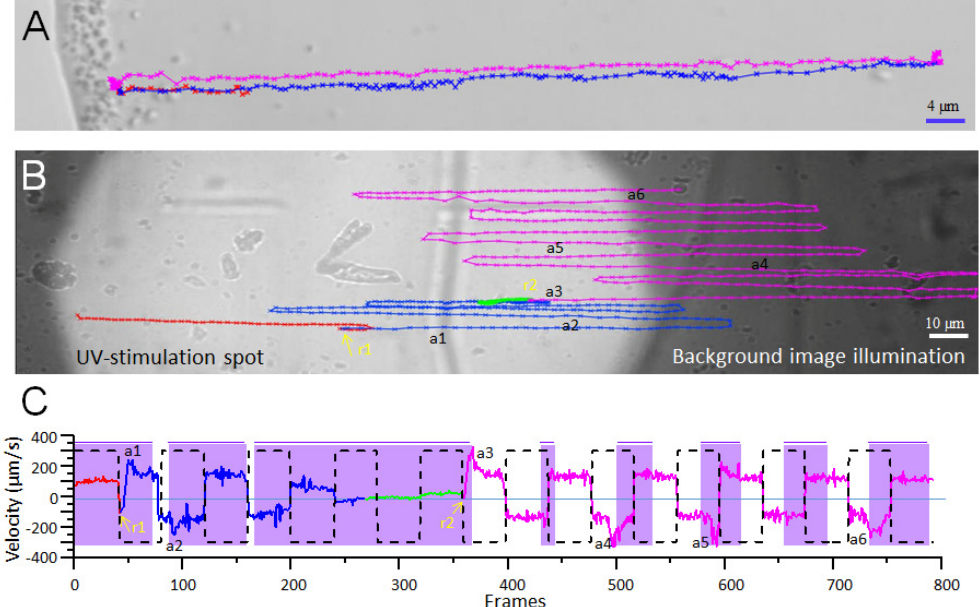
Figure 3. Ping-pong motion and photo-sensitive motility. ( A ) a magnetotactic bacillus of ~ 4 µm swims northward (red track) until the edge of the droplet. Then, it swims southward, opposite to the north-seeking swimming direction to the center of the droplet (blue track), which is followed by a returning north-seeking (magenta track). ( B ) is a representative photosensitive swimming behavior of magnetoglobules and ( C ) is an ImageJ analysis of the data [8]. The dot-line square curve indicates the north direction of the alternating magnetic field. Positive velocity means that the magnetoglobule swims from left to right on the image whilst the negative values are opposite. The velocity curve colors in ( C ) correspond to the same colors of the swim tracks in ( B ). When the velocity curve is on the same side as the field curve using zero velocity line as a reference, the magnetoglobule exhibits a north-seeking magnetotaxis (e.g., red and green tracks), otherwise it displays a south-seeking magnetotaxis (blue and magenta tracks). Violet areas show the swimming of the magnetoglobule in the UV spot. Yellow arrows with r1 and r2 indicate the sudden change of swimming direction to south-seeking; a1 to a6 show the accelerations.